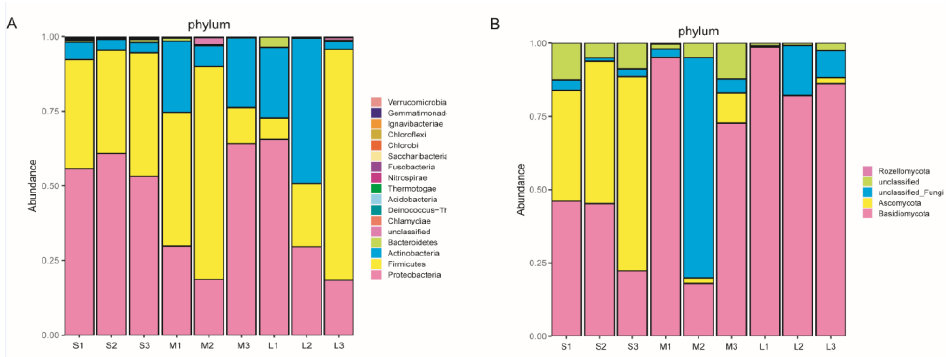
Figure 5. Microbial community structure at different developmental stages of Paphiopedilum armeni- acum at the phylum level. ( A ) Relative abundance of bacterial taxa of each group. ( B ) Relative abun- dance of fungal taxa of each